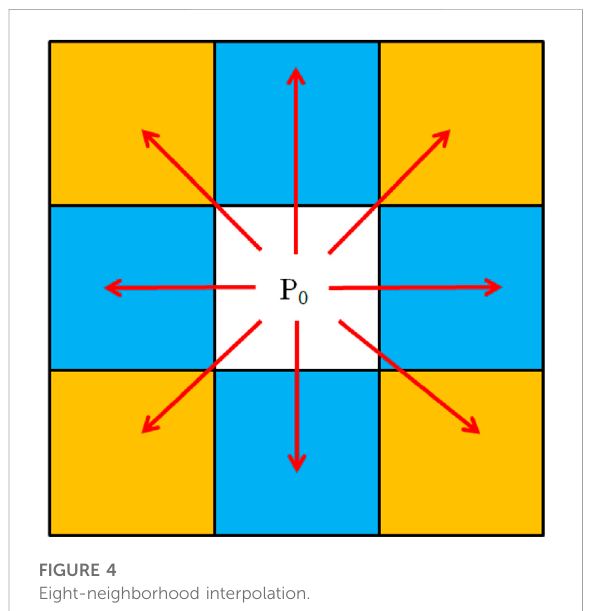
FIGURE 4 Eight-neighborhood